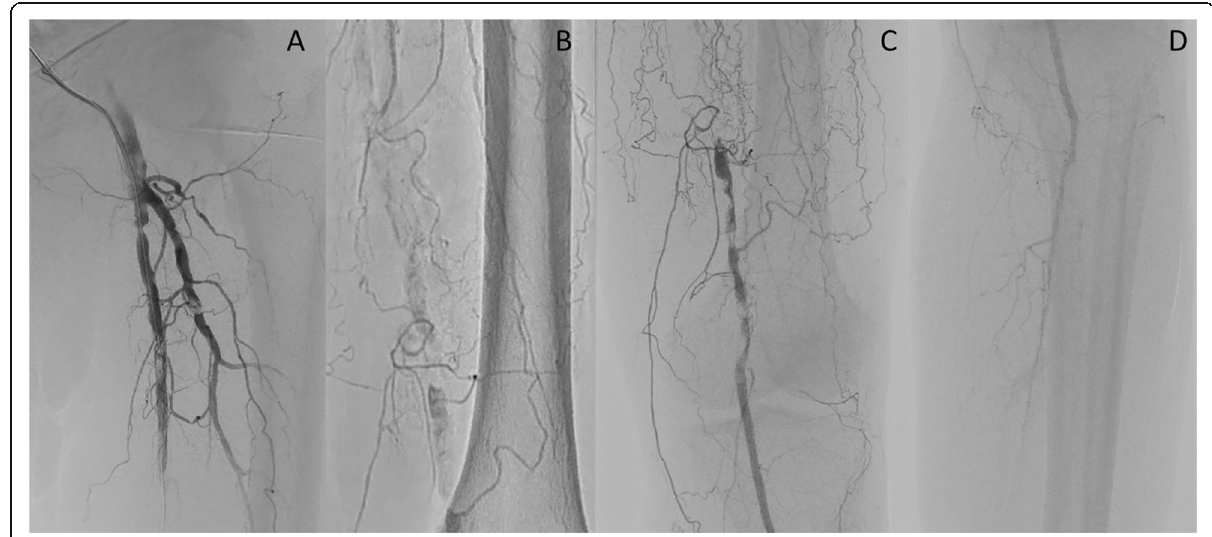
Fig. 1 Control angiography. a Digital subtraction angiography showing severe stenosis with severe calcification in the left proximal superficial femoral artery. b Digital angiography of the middle to distal part of the left superficial femoral artery showing chronic total occlusion with severe calcification. c : Digital subtraction angiography of the distal superficial femoral artery to the proximal popliteal artery showing severe tandem stenosis with severe calcification. d Digital subtraction angiography of the below-the-knee lesions showing the total occlusion of three